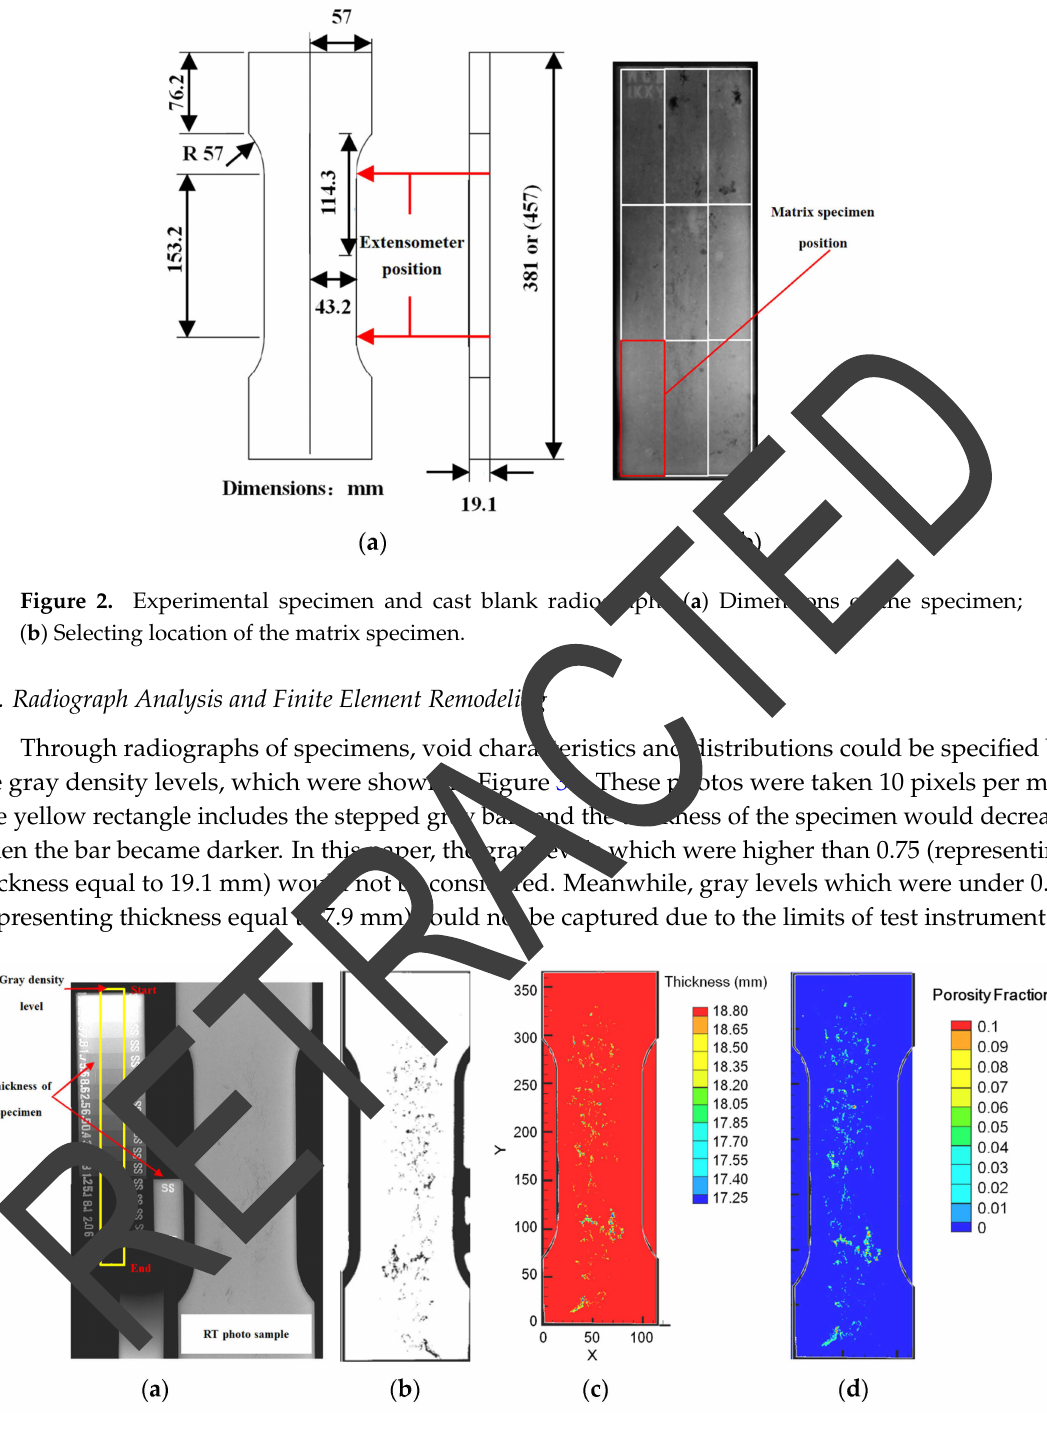
Figure 3. Porosity fraction result: ( a ) Original radiograph; ( b ) Image of defect after shadow filtration; ( c ) Thickness distribution in the specimen; ( d ) Porosity fraction field